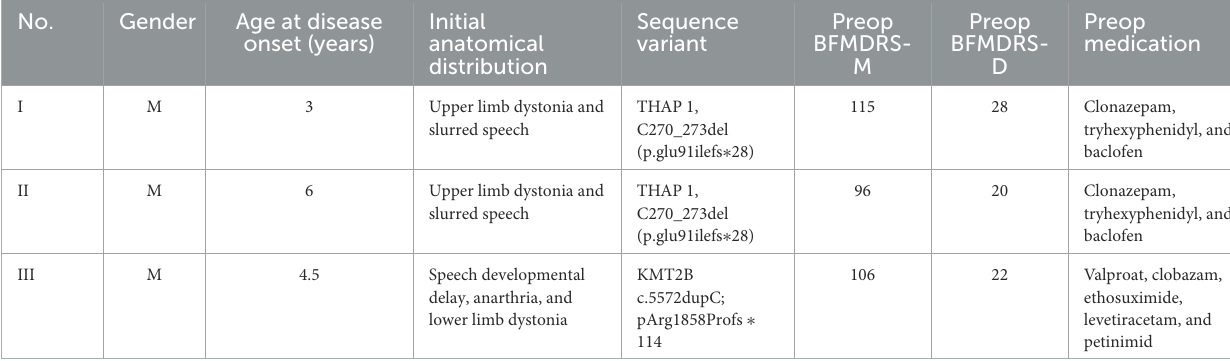
TABLE 1 Preoperative characteristics of dystonia patients included in the study.